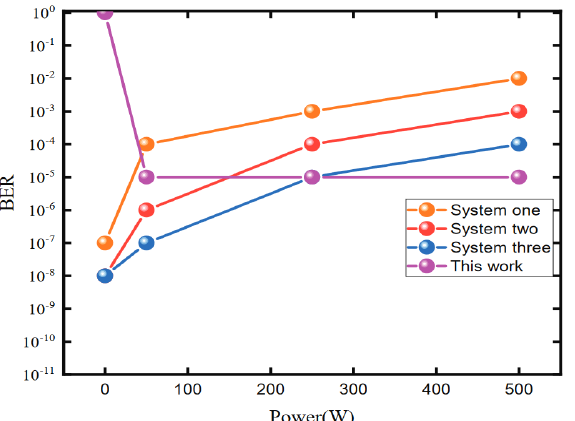
Figure 9. Variation of bit error rate with output power. System one corresponds to the system proposed in [13]; System two corresponds to the system proposed in [15]; System three corresponds to the system proposed in [21].